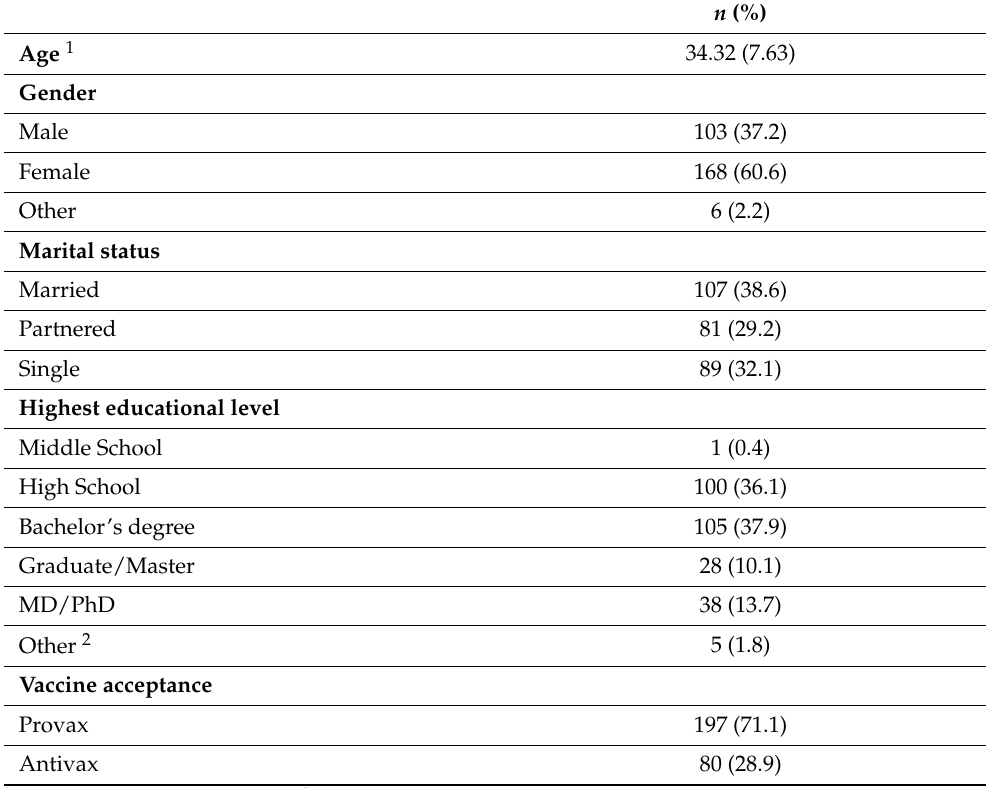
Table 1. Participants’